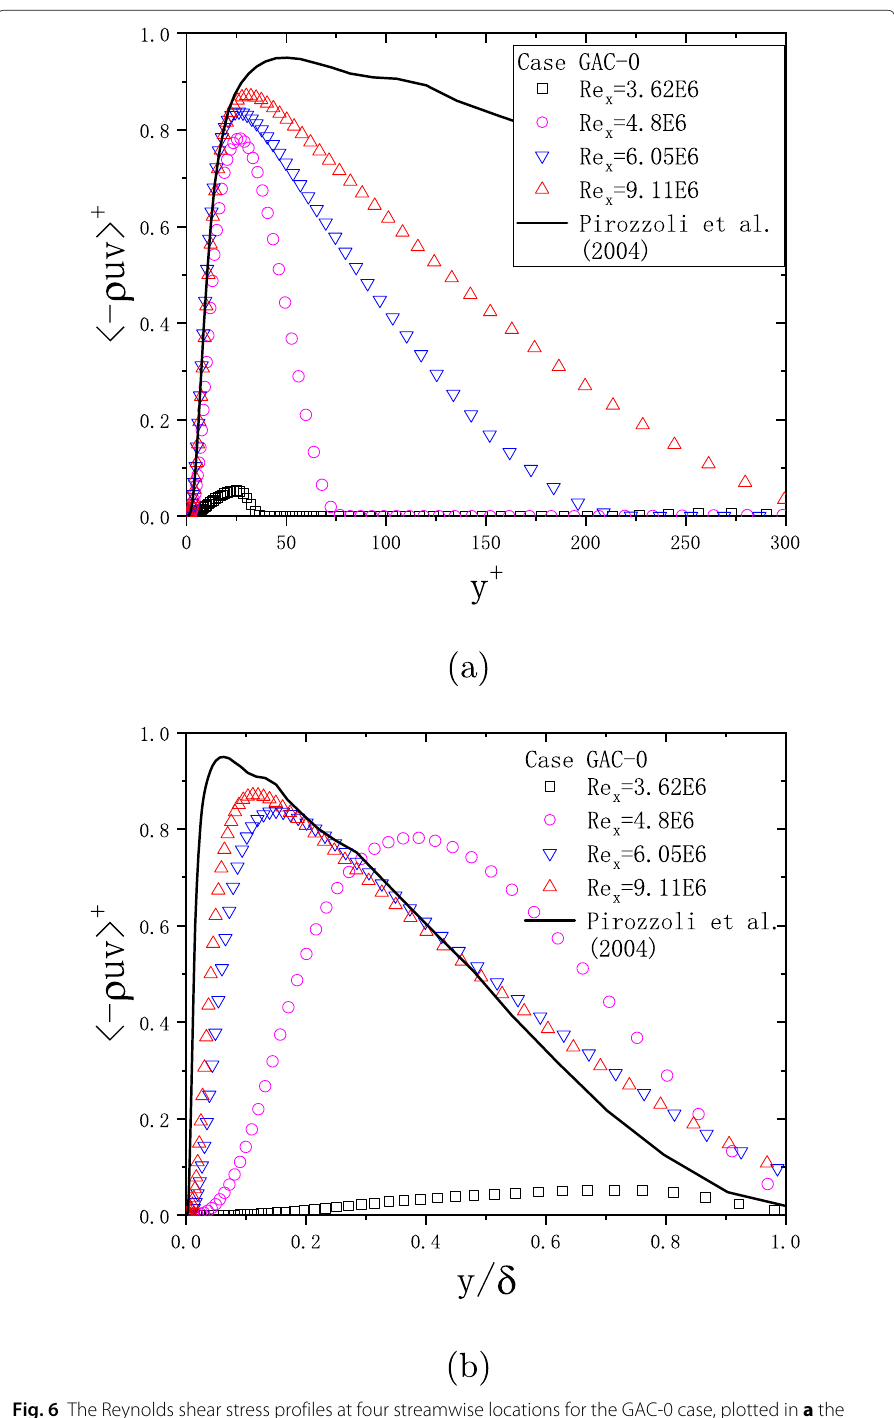
Fig. 6 The Reynolds shear stress profiles at four streamwise locations for the GAC-0 case, plotted in a the inner coordinate and b the outer coordinate. Re x = 3.62 E 6 indicates the transition onset location and Re x = 6.05 E 6 indicates the transition peak location. Solid line denotes the DNS data of Pirozzoli et al. for an adiabatic flat-plate TBL at Ma = 2.25